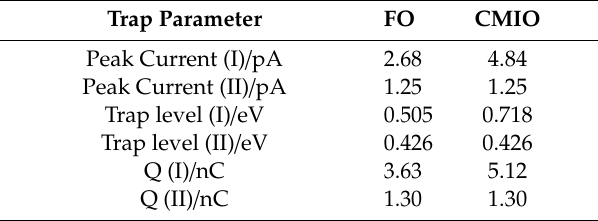
Table 4. Characteristics of TSC trap parameters of insulating oil.